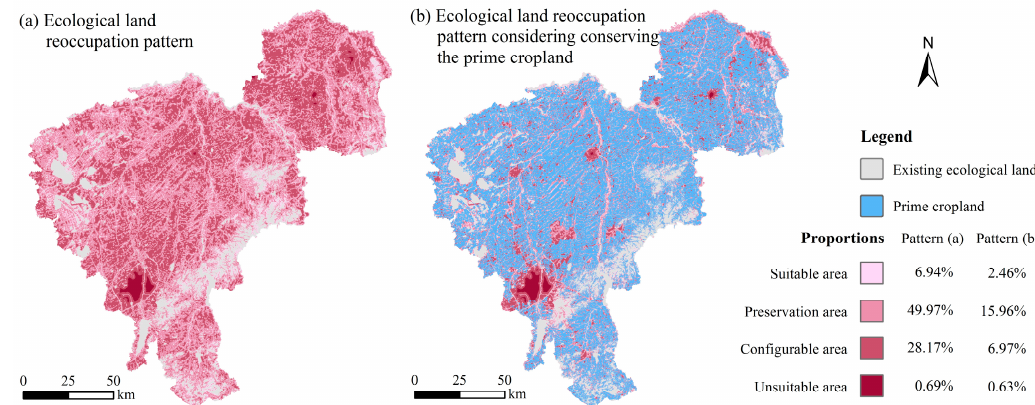
Figure 6. Ecological land reoccupation pattern. ( a ) Based on multiple constraints; ( b ) Considering conserving the prime cropland.